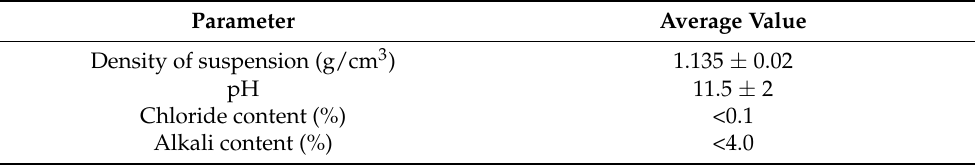
Table 6. Physical parameters of the